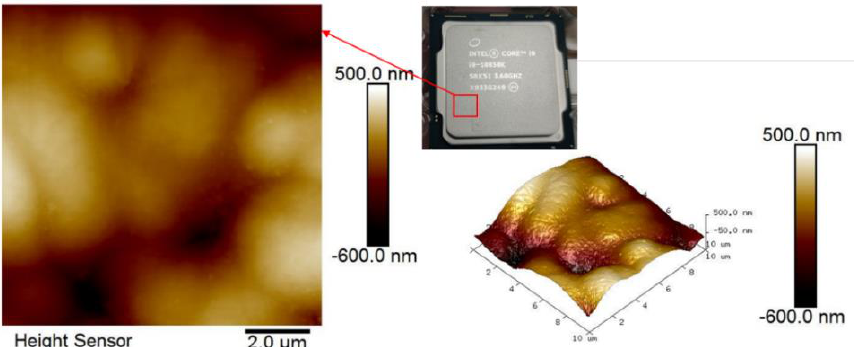
Figure 8. Schematic diagram of bubble growth on CPU direct-cooling wall. The size of the CPU used in this experiment is 30 mm × 30 mm × 2 mm. The heat transfer surface is a pure copper matte surface. The contact angle of the HFE 7100 liquid on the copper cover of the CPU was determined to be 10° through a liquid angle tester (Siderns DES-PHa). The average surface roughness of the probe was measured using a German Bruker Dimension Icon atomic force microscope (AFM; probe model: Scan Asyst-Air; scanning mode: Scan Asyst in Air; scanning frequency: 0.5 Hz; scanning area: 10 microns) in order to record the space trajectory of the probe with Ra of 135 nm (from three topographic images with a scanning range of 10 microns, it can be seen that image Ra is 156 nm, 112 nm, and 138 nm), as shown in Figure 9. From the three topography images with a scanning range of 10 microns, it can be seen that the actual surface areas were 104 μm 2 , 104 μm 2 , and 103 μm 2 ; therefore, the effective heat transfer area ratios r:1 (the actual surface area to the projected area ratio) were 1.04, 1.04, and 1.03, respectively. Taking their average value, we obtain a sample effective heat exchange area ratio of 1.04.